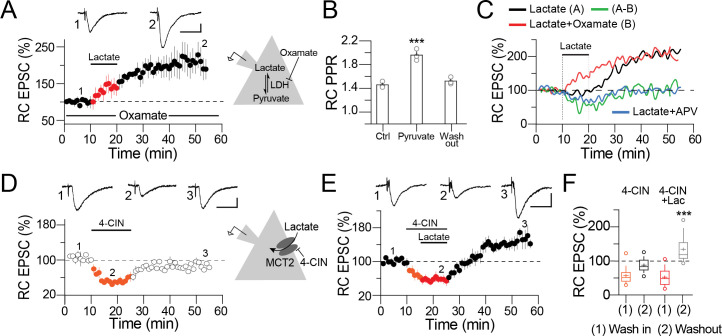
Synaptic potentiation is independent of lactate metabolism.A) Averaged time-course graph and representative current traces acquired at the indicated time of the time-course graph. Before the beginning of the experiment, the slices were preincubated (15–20 min) with the non-competitive blocker of the lactate dehydrogenase enzyme, oxamate (10 mM), to block the conversion of lactate to pyruvate. Oxamate did not interfere with synaptic potentiation induced with lactate. B) Bar graphs, Effect of pyruvate (2 mM) on the PPR of the RC EPSC. Similar to lactate, pyruvate exerts a transitory, presynaptic modulation of the synaptic transmission. (One-way ANOVA on ranks, Tukey, ***p < 0.001). C) Temporal sequence of the predictable presynaptic and postsynaptic contribution of lactate to synaptic potentiation. The solid line shows the time course of the normalized amplitude of the RC EPSC during baseline, lactate perfusion, and lactate washout. Red line, time course of the normalized RC EPSC response preincubated with oxamate. The subtraction of the normalized values of lactate minus the values obtained with oxamate (green line). This time course shows similar kinetics to those observed when lactate was perfused in the presence of D-APV (blue line). D) Averaged time-course graph and representative current traces acquired at the indicated time of the time-course graph showing the effect of 4-CIN (0.5 mM) on the RC EPSC. E) Averaged time-course graph and representative traces acquired at the indicated time showing the effects of 4-CIN and the subsequent perfusion of lactate (2 mM) on the RC EPSC. 4-CIN depressed the evoked response and further perfusion of lactate triggers synaptic potentiation. F) Boxplots summarizing the actions of 4-CIN or 4-CIN + lactate during perfusion of the drugs (wash in) and at 30 min (washout) on the RC EPSC amplitude (One-way ANOVA on Ranks, Tukey, *p < 0.001). Calibration bars: Panel A: 20 pA / 25 ms; panel B: 50 pA / 25 ms; panel C and D: 20 pA / 20 ms.